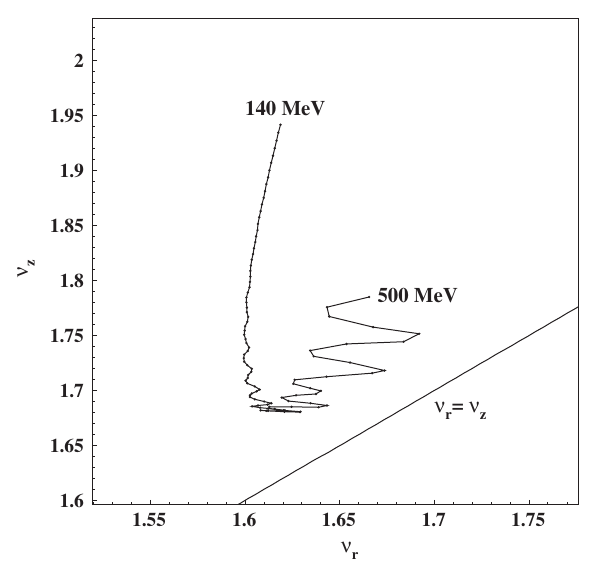
FIG. 6. Tune diagram of the medical cyclotron with variable energy extraction shown in Fig.